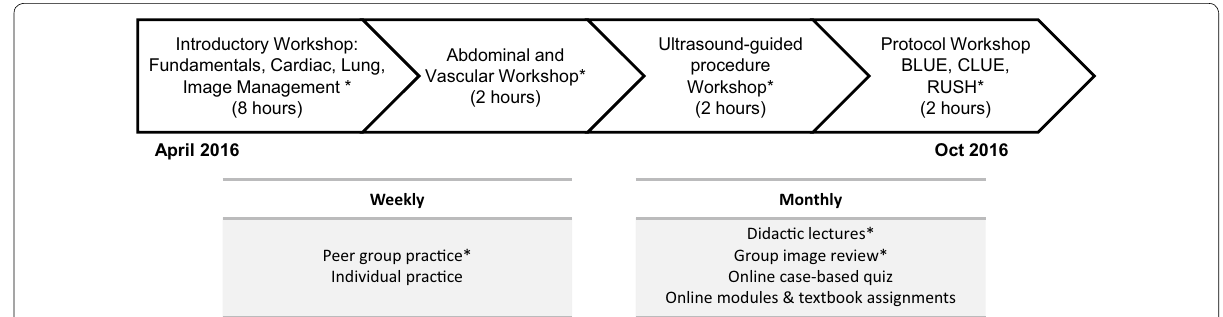
Fig. 1 Curricular elements of 6-month point-of-care ultrasound curriculum for internal medicine faculty. *Curricular elements that qualified for CME credits. BLUE bedside lung ultrasound in emergency, CLUE cardiopulmonary limited ultrasound examination, RUSH rapid ultrasound for shock and